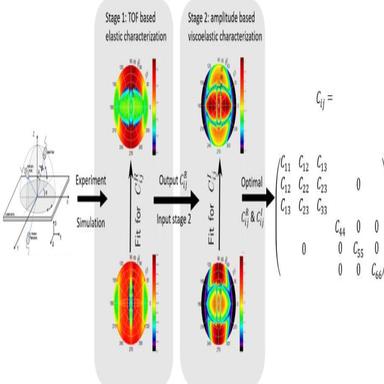
Schematic of the developed two-stage inversion procedure. The first stage fits the TOF P-UPS landscape to retrieve a best guess on the nine elasticity constants of the investigated sample. The second stage uses the available amplitude P-UPS data combined with the best guess results of stage one to determine the full set of the viscoelastic tensor coefficients.